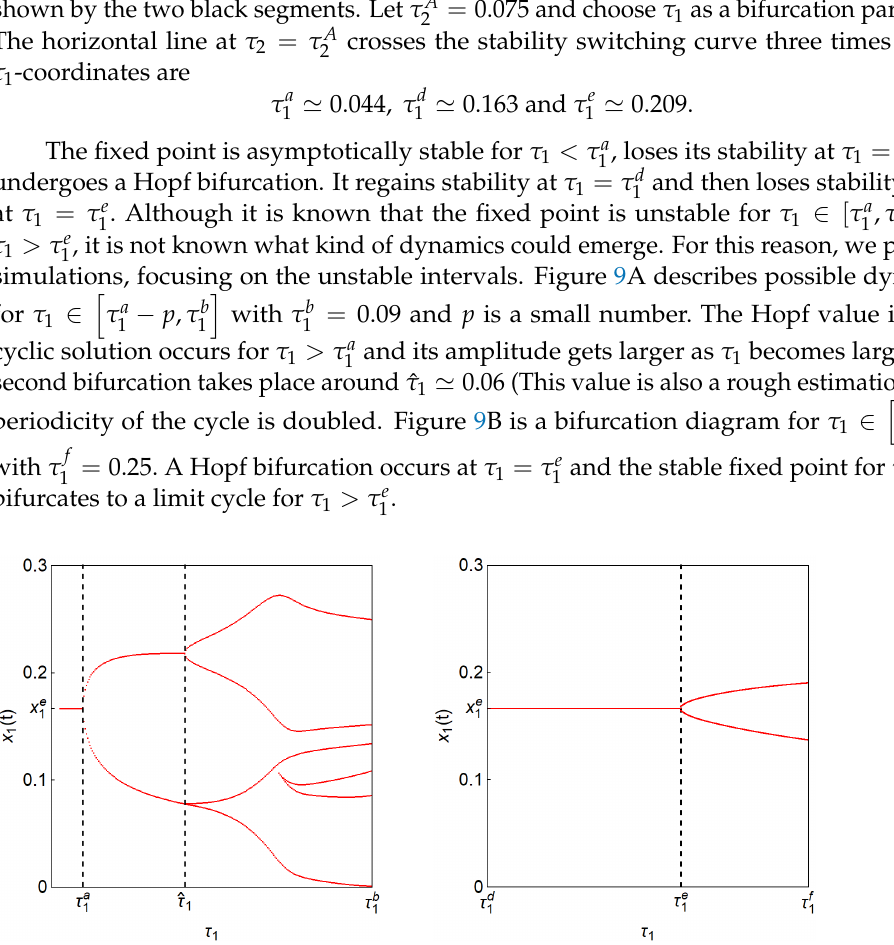
2 = (cid:28) m (= 0 : 075) 2 2